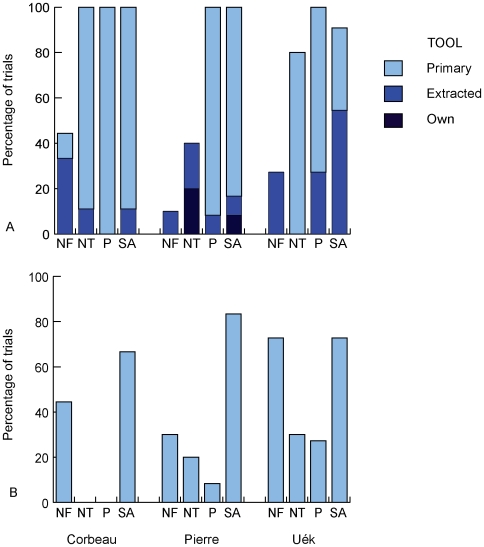
Results from control conditions in Experiment 2.Panel (A) shows the percentage of trials in which subjects probed into the food-frame, split according to which tool was used first. Panel (B) shows the percentage of trials in which a tool/object was extracted from the tool-frame. Secondary-Any (SA) trials are also displayed to allow for comparison with an experimental condition. Trial types are coded as follows: NF = No-Food; NT = No-Tools; P = Primary; SA = Secondary-Any.